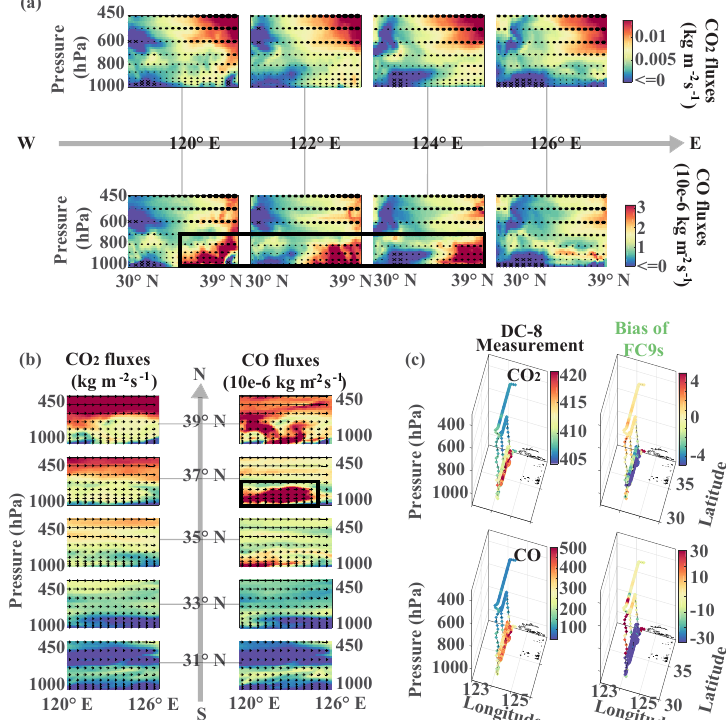
Figure 6. Case study for the flight on 24 May (UTC time). (a) Vertical distributions (hereafter denoted as “sections”) of fluxes (kgm − 2 s − 1 ) at 09:00UTC on 25 May (South Korean time) in meridional direction. Dots represent meridional winds going from west to east (i.e., from China to South Korea) and crosses represent meridional winds with the opposite direction. Sizes of the dots and crosses are proportional to the wind speed. “Sections” at the top are for CO 2 fluxes and those at the bottom are for CO fluxes. (b) “Sections” of fluxes (kgm − 2 s − 1 ) at 09:00UTC on 25 May (South Korean time) are in the zonal direction. Arrows represent meridional winds. “Sections” in panel (b) share the same color bar as panel (a) . (c) The DC-8 aircraft measurements (left column) and bias of CAMS along the flight track over the West Sea (right column). The top row is for CO 2 and the bottom row is for